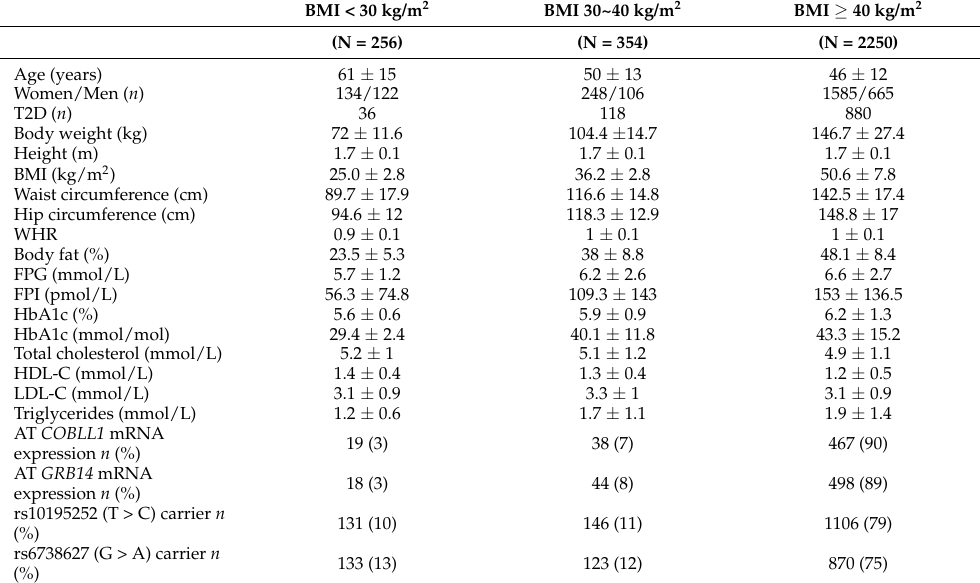
Table 2. Anthropometric and metabolic characteristics of the studied